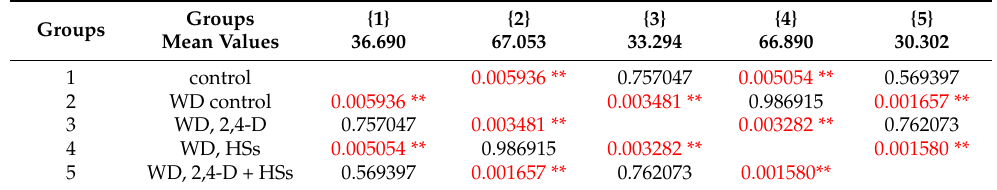
Table 9. ANOVA test for root ABA content followed by Duncan test. Values in the cells correspond to p for the difference between the mean values; p ≤ 0.05 is marked with *; p ≤ 0.01—with ** for control plants untreated with either bacteria or HSs and plants grown under water deficit (WD): con- trol, plants treated with Pseudomonas plecoglossicida 2,4-D (2,4-D), humic substances (HSs) and their combinations (2,4-D + HSs).